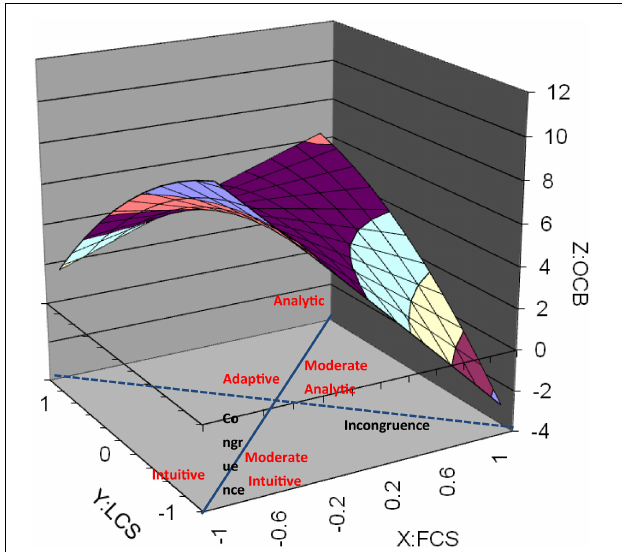
FIGURE 3 | Response surface graph of